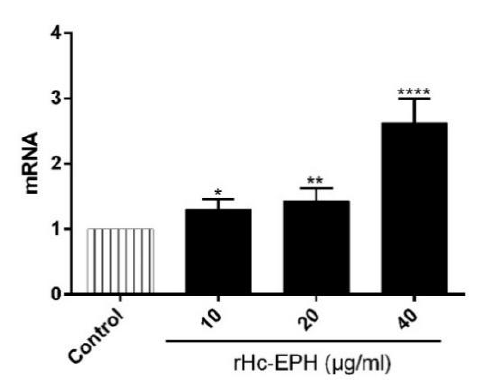
Figure 7. Relative expression of interleukin-9 (IL-9) cytokines in goat PBMCs stimulated by rHcEPH was evaluated. Cells were incubated with serial concentrations of rHcEPH and PBS for 12 h, the mRNAs were quantified by FQ-PCR. The data is expressed as mean ± SEM of three independent experiments (* p < 0.05, ** p < 0.01, **** p < 0.0001).